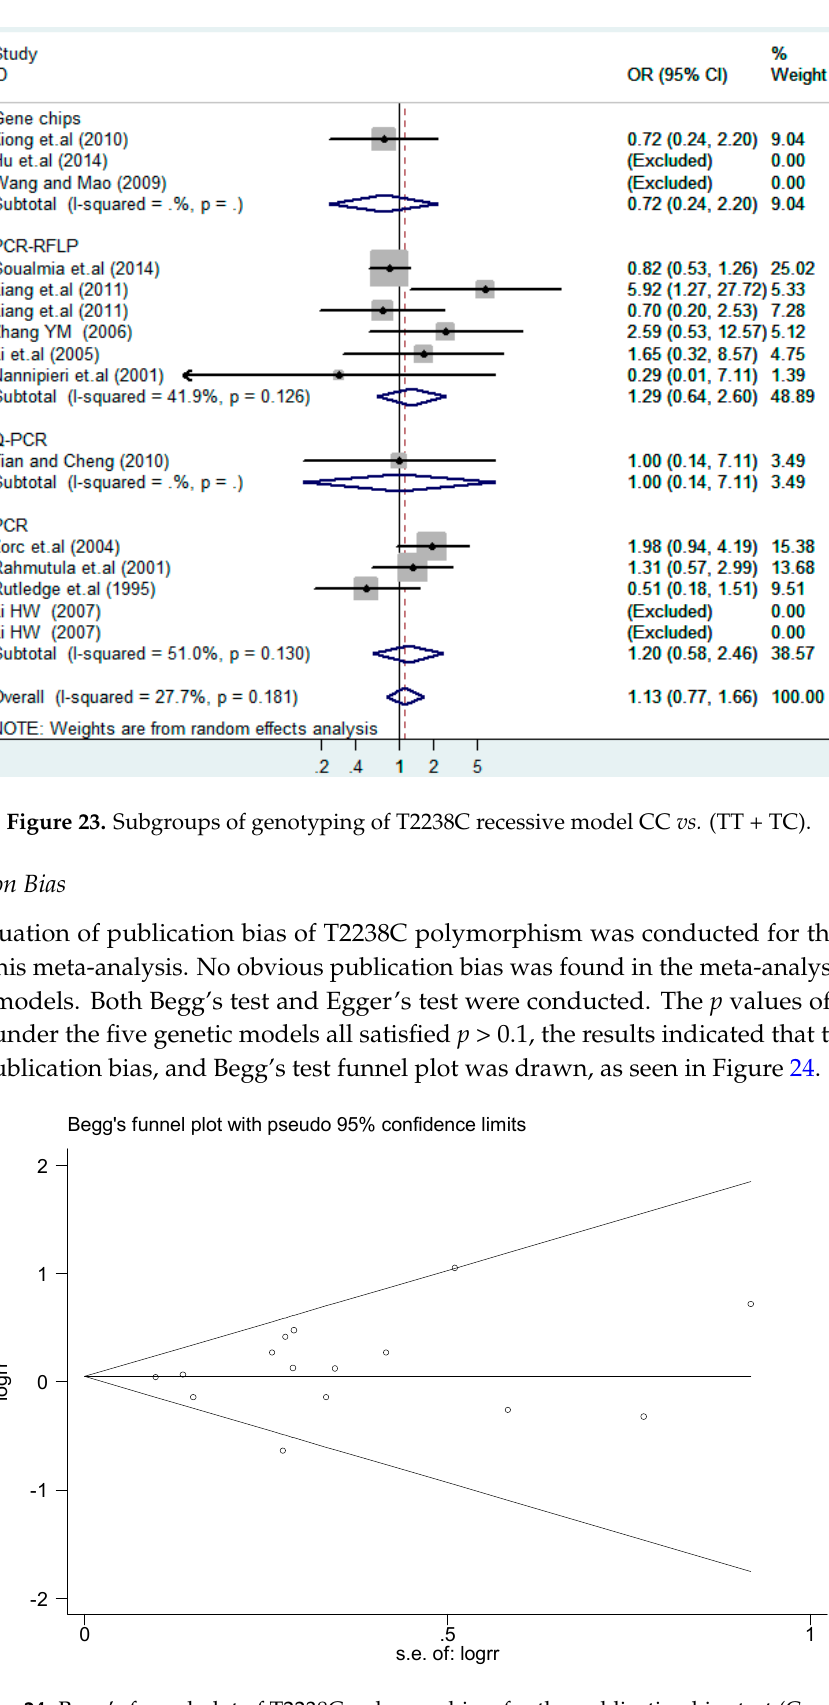
Figure 24. Begg’s funnel plot of T2238C polymorphism for the publication bias test (C vs. T).